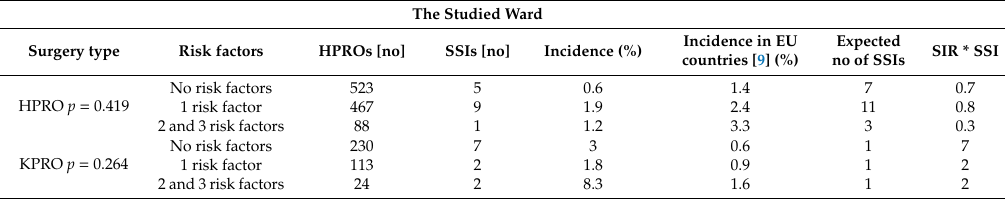
Table 4. Incidence of SSI in 2012–2018 in patients of the Trauma and Orthopedic Ward compared with NHSN (2006–2008) including risk